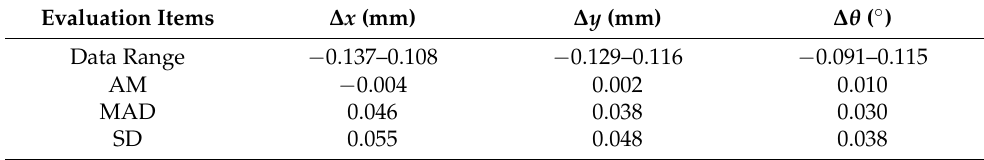
Figure 18. Error bar describing the deviation of measurement data from the reference value . Table 1. Summary of evaluation items and experimental results of repeat positioning accuracy .